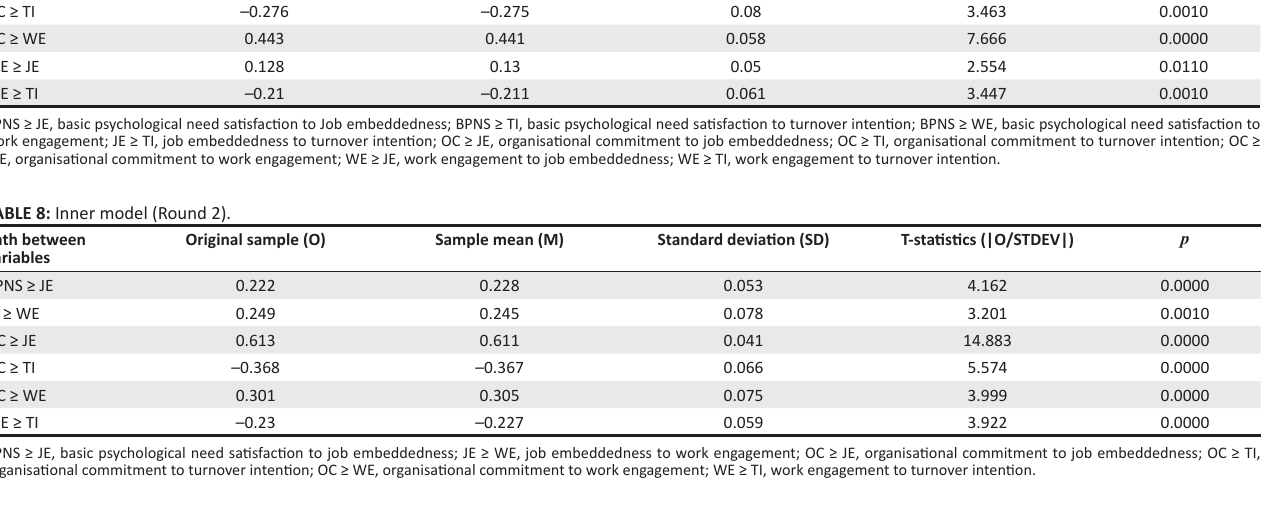
TABLE 9: Variance of final model explained.